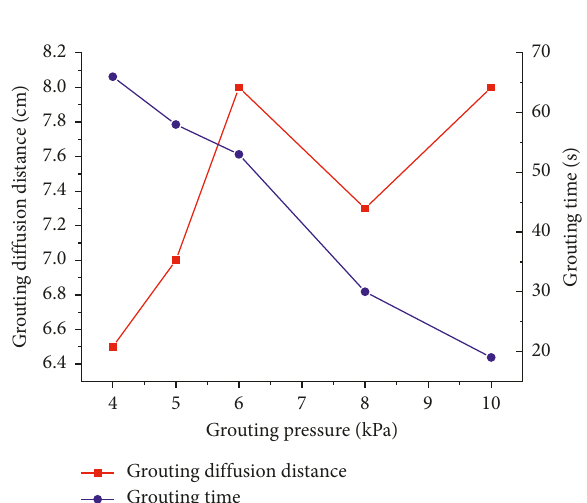
Figure 6: Effect of the static pressure grouting under different grouting